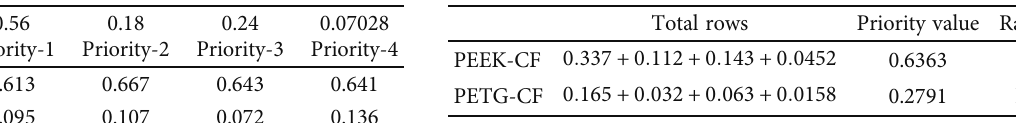
Table 5: Decision matrix with criteria. Table 6: Final decision